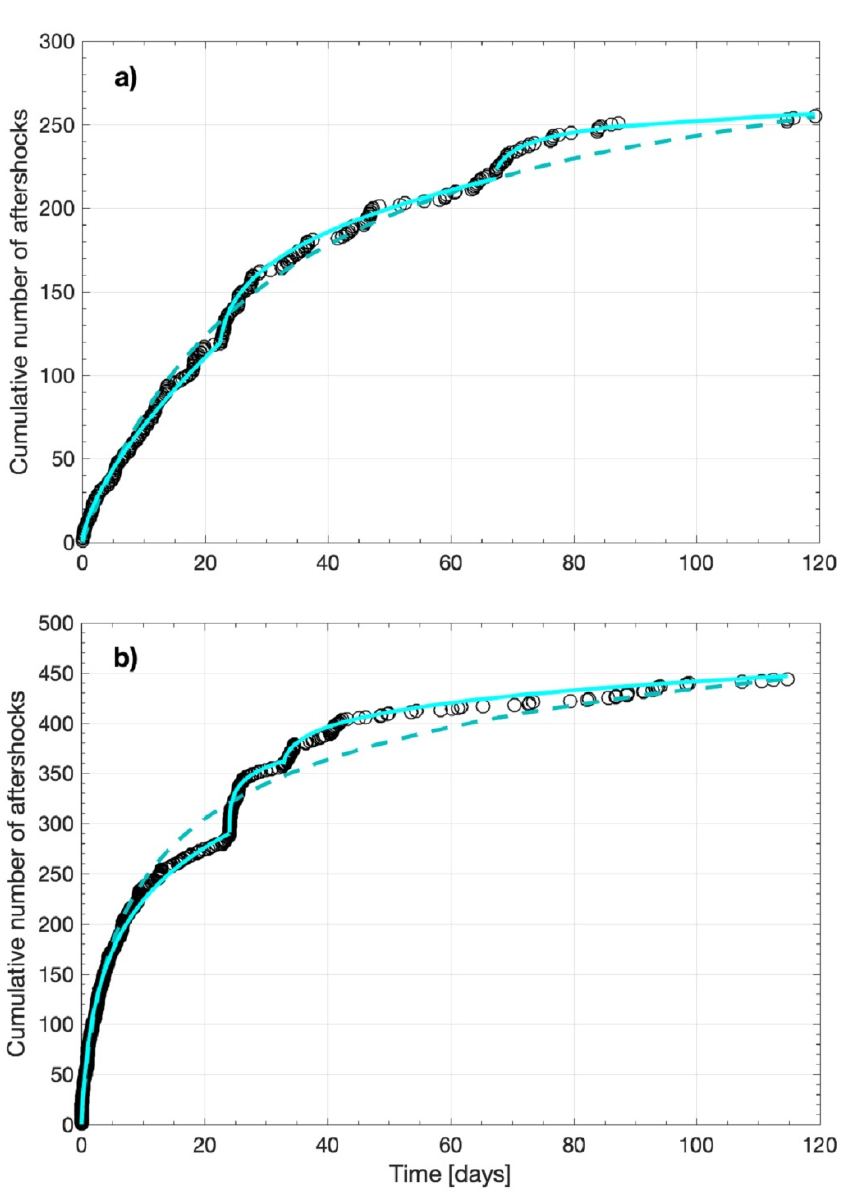
Figure 16. The cumulative number of events for M ≥ M c (symbols) with time that followed the Mw6.0 mainshock in the ( a ) NE cluster and ( b ) the SW cluster. The solid lines represent the composite model of three modified Omori regimes, while the dashed line the model for a single modified Omori regime, for the parameter values shown in Table 7.